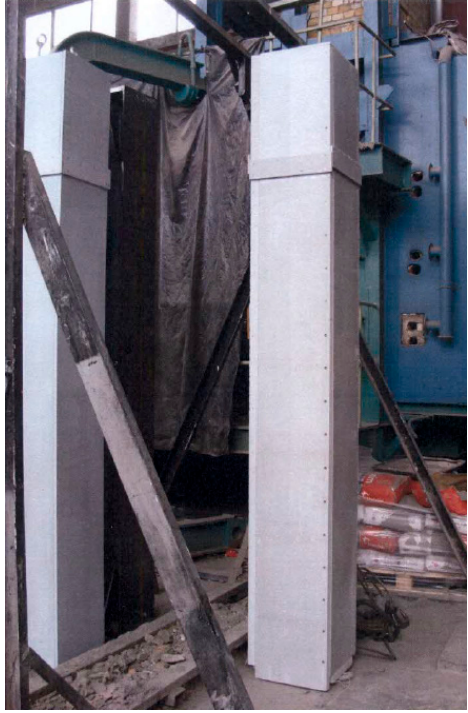
Figure 6. Steel column test specimens with fireproof slabs cladding.